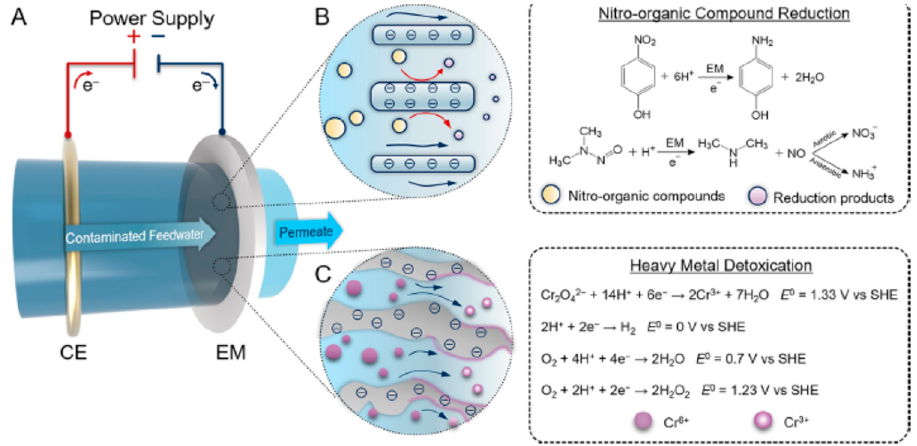
Figure 12. Shows the electrochemical reduction of toxic contaminants using an electrified membrane (EM). ( A ) Schematic diagram of a typical electrified flow-through filtration system consisting of a DC power supply, a downstream cathodic EM serving as the working electrode, and an anodic metal ring serving as the counter electrode (CE). From the CE to the EM, the contaminated feed water flows through the system. It should be noted that the system also makes use of an upstream EM. EM reaction mechanisms (dashed line boxes) and schematics (dotted circles) ( B ) Nitro-organic compound (e.g., 4-nitrophenol and NDMA) and ( C ) heavy metal (e.g., Cr 6+ ) mediated reduction [162].